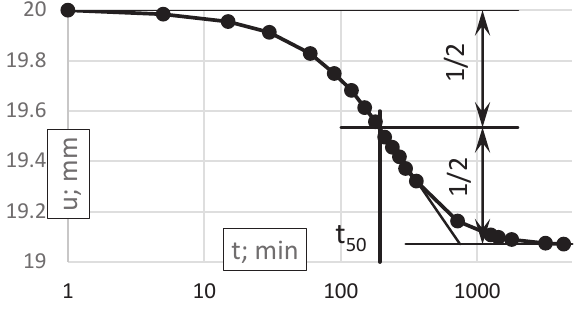
Figure 6. Cassagrande estimation of Cv.